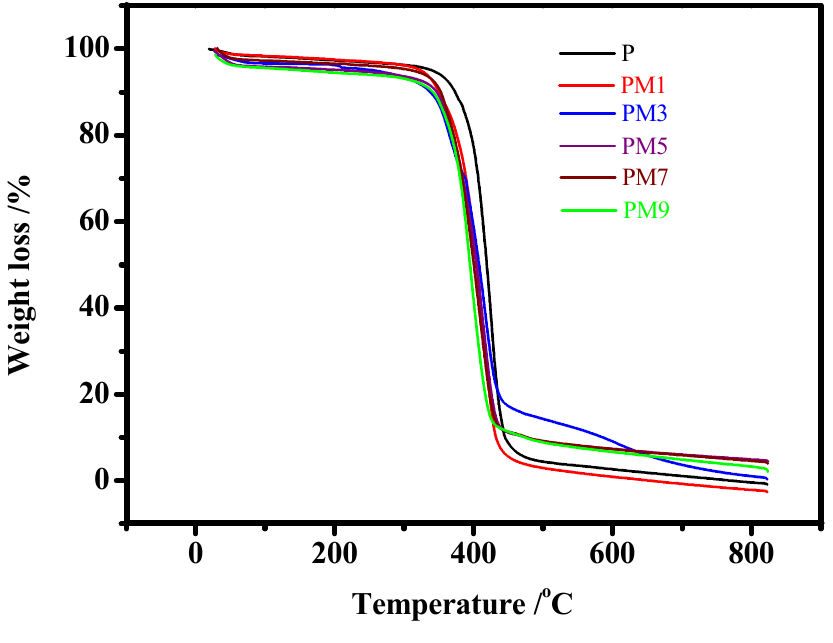
Figure 6. TGA curves of P, PM1, PM3, PM5, PM7, and PM9.